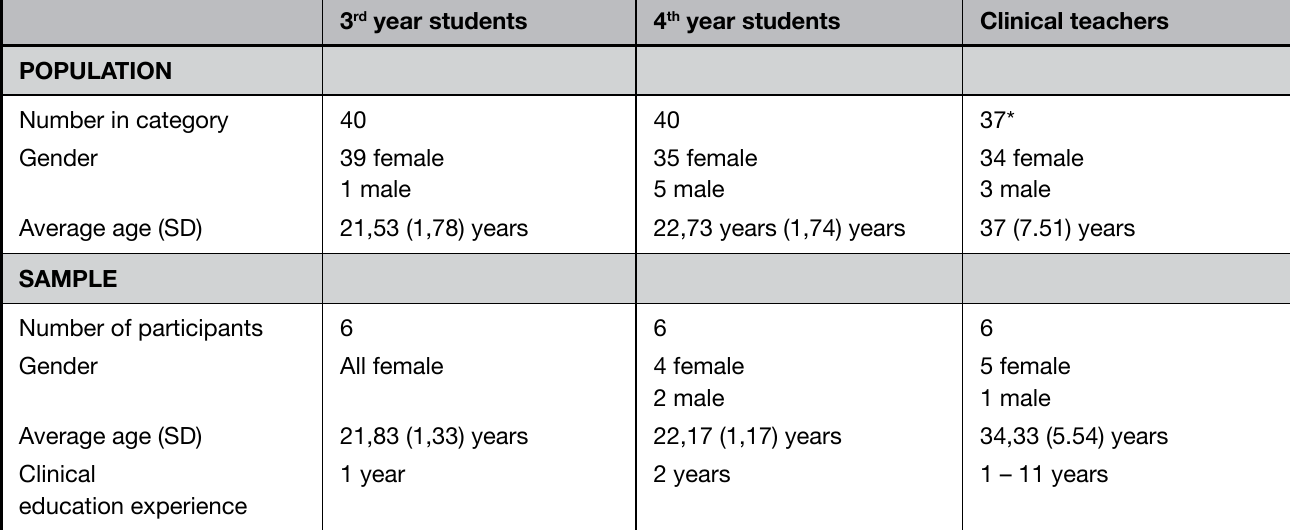
Table 1: Profile of the case population and sample